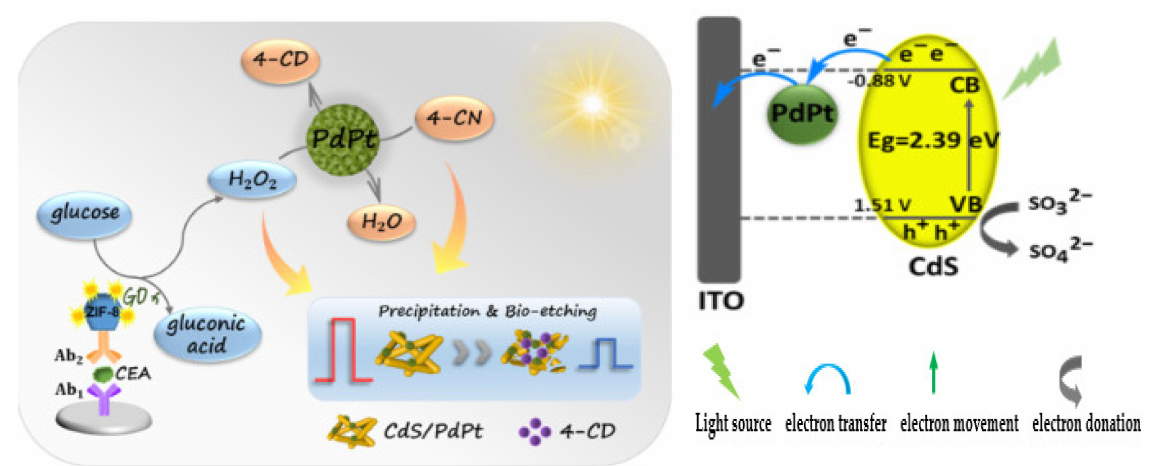
Figure 22. Schematic Illustration for the Detection Mechanism of CdS/PdPt–Based PEC biosensor and band structure of the PEC system under illumination. e: electron; h: hole: VB: valence band; CB: conduction band: Eg: energy gap. Reprinted with permission from [140], published by American Chemical Society,